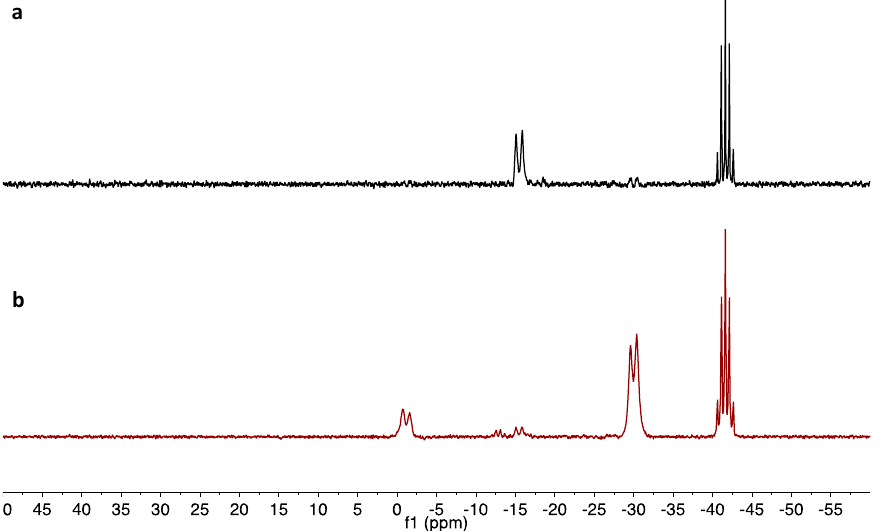
Figure 1. ( a ) 11 B NMR analysis of Mg(BH 4 ) 2 , 1 equiv. tetraglyme (G4), 200 °C, 8 h to generate the major product of B 12 H 122 − ; ( b ) 11 B NMR analysis of Mg(BH 4 ) 2 , 1 equiv. monoglyme (G1), 200 °C, 8 h to generate the major product of B 10 H 102 − .